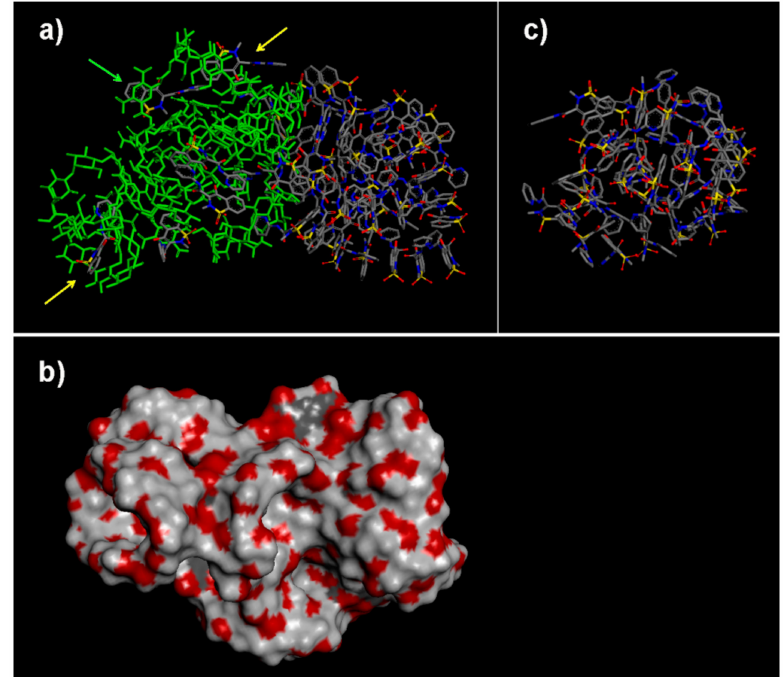
Figure 12. Panel ( a ) shows the optimized geometry assumed by the NS / 40 PX drug molecules system at the end of the MD run displaying some host–guest inclusion complexes (see the arrows). All the other molecules are on the external surface of the NS. Panel ( b ) shows the solvent-accessible surface area without the PX molecules for clarity (see the color codes in Figure 5). Panel ( c ) shows the PX aggregate formed by 32 molecules adsorbed on the NS surface well-ordered in an almost spherical shape in